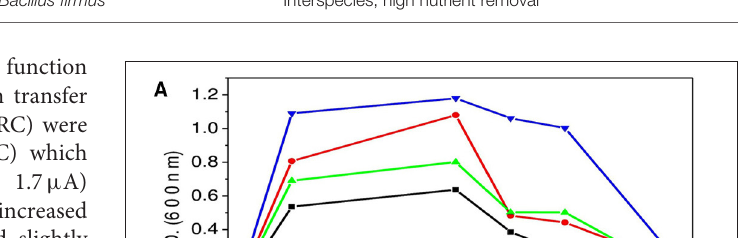
2 constituted with P. otitidis + B. circulans + B. subtili s